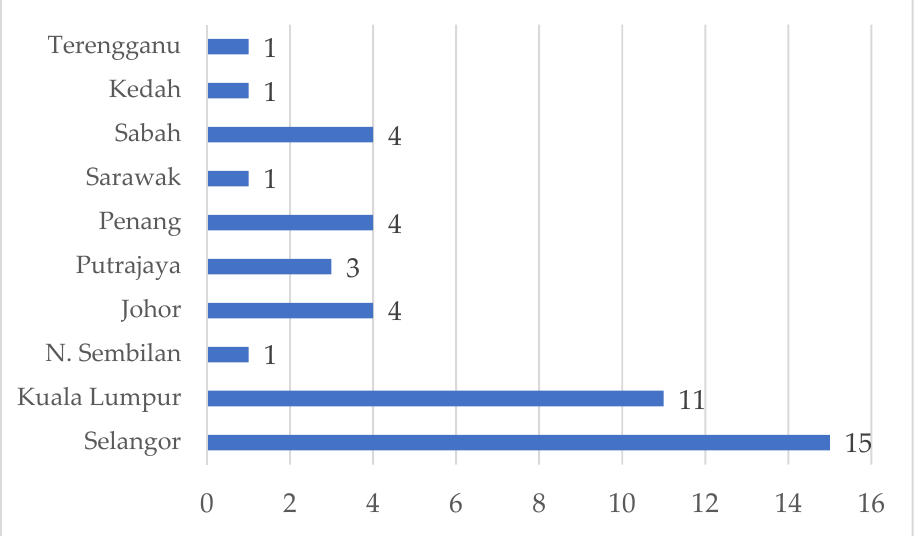
Figure 4. Distribution of articles based on location ( n = 45).